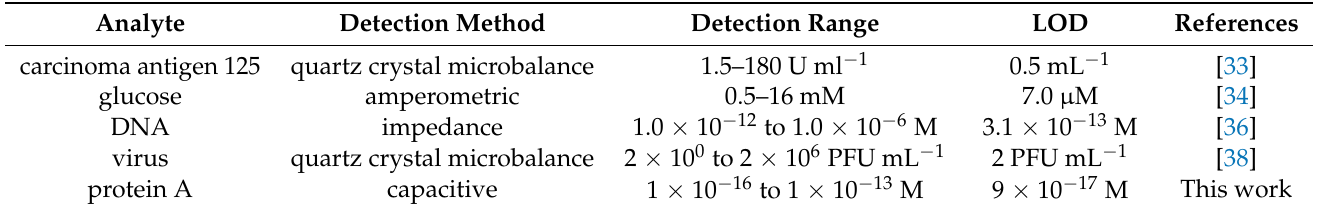
Table 2. Comparison of the present study with related works focused on layer-by-layer immobiliza- tion